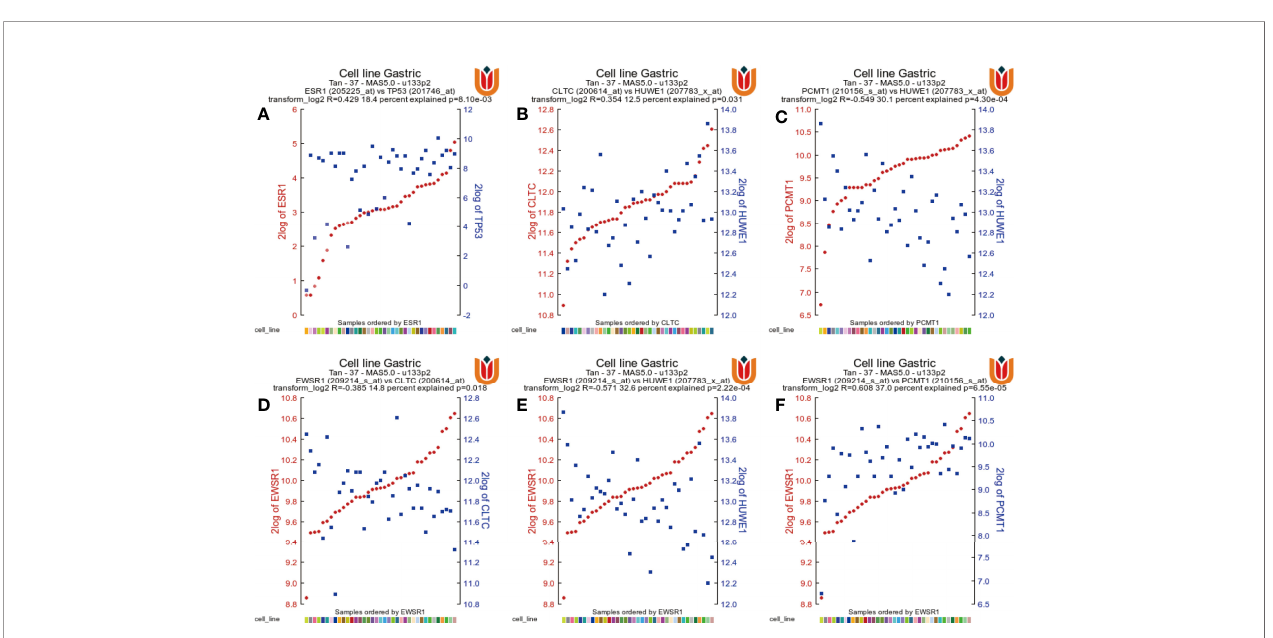
FIGURE 12 | The gene correlations were revealed by the R2 Platform. (A) Correlation between the ESR1 gene and the TP53 gene ( R = 0.429, P = 8.10e − 03). (B) Correlation between CLTC and HUWE1 ( R = 0.354, P = 0.031). (C) Correlation between PCMT1 and HUWE1 ( R = 0.549, P = 4.30e − 04). (D) Correlation between EWSR1 and CLTC ( R = 0.385, P = 0.018). (E) Correlation between EWSR1 and HUWE1 ( R = 0.571, P = 2.22e − 04). (F) Correlation between EWSR1 and PCMTA ( R = 0.608, P = 6.55e −